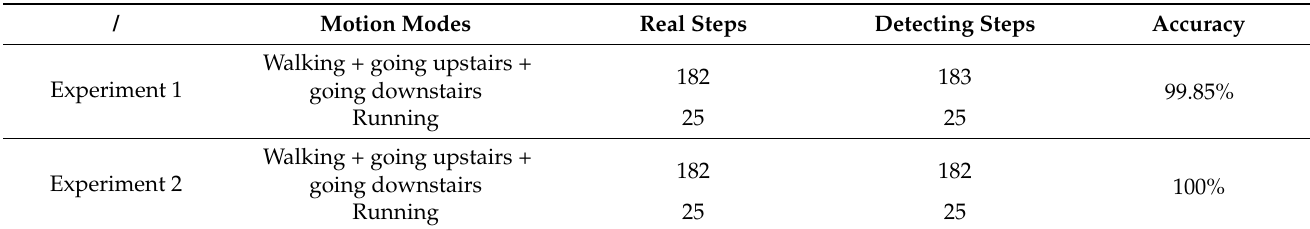
Table 4. Detection of zero-velocity interval.